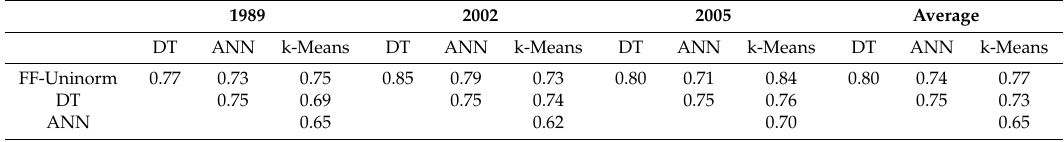
Table 3. Rand Index agreement validity measure among FF-Uninorm, DT, ANN and Table 3 . Rand Index agreement validity measure among FF-Uninorm, DT, ANN and k-means.